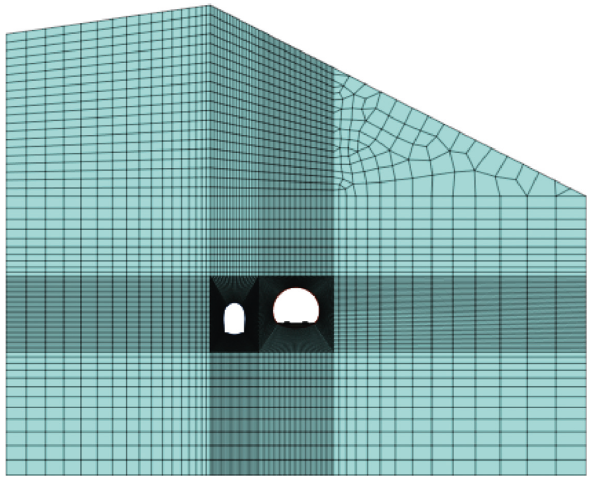
Figure 7: Mapping mesh of the numerical model. Table 2: Physical properties of the numerical